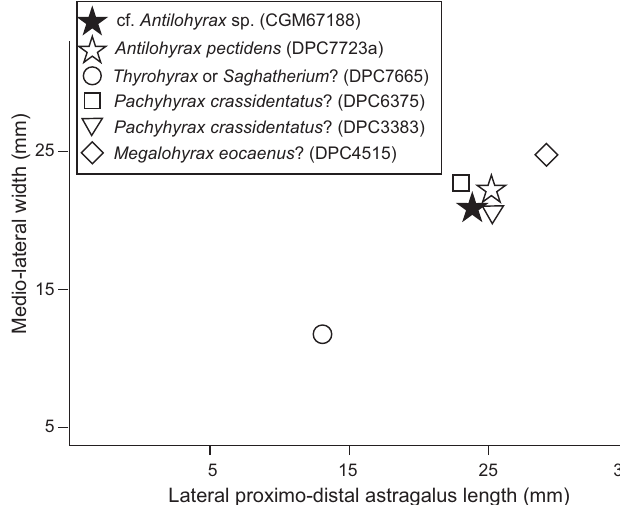
Fig. 9. Bivariate plot of a hyracoid astragalus, cf. Antilohyrax sp. (CGM67188) from the BOTM, early Oligocene, Minqar Tibaghbagh, Qattara Depression, Egypt, compared with specimens from the Jebel Qatrani Formation of the Fayum Depression, Egypt. Tibaghbagh speci- men based on estimated dimensions; Thyrohyrax or Saghatherium ?, Pachyhyrax crassidentatus ?, and Megalohyrax eocaenus ? dimensions cal- culated from Rasmussen et al. (1990: fig. 1a, d, e); Antilohyrax pectidens from Rasmussen and Simons (2000: fig. 6a, b).